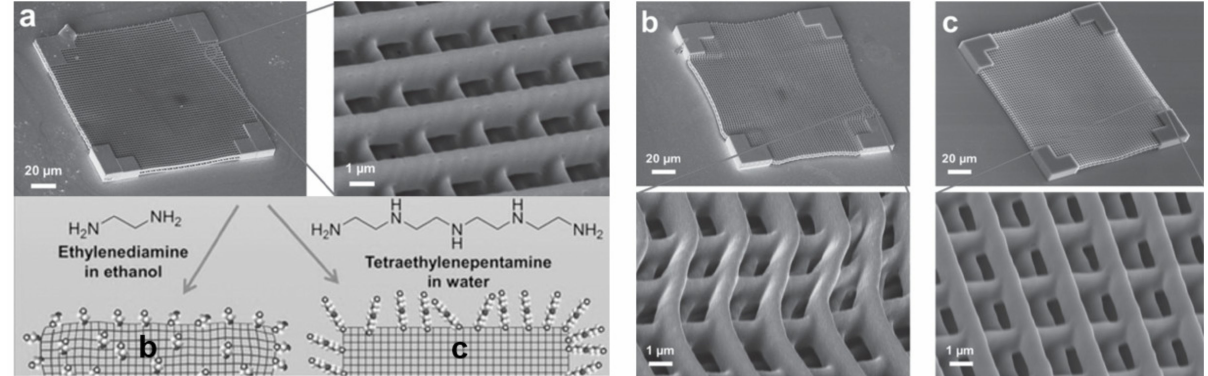
Figure 13. SEM images of SU-8 micro-lattices ( a ) as-fabricated, ( b ) after conventional amination with ethylenediamine in ethanol and ( c ) after amination using TEPA in water. Figure adapted with permission from Ref. [83] Copyright 2014 John Wiley and